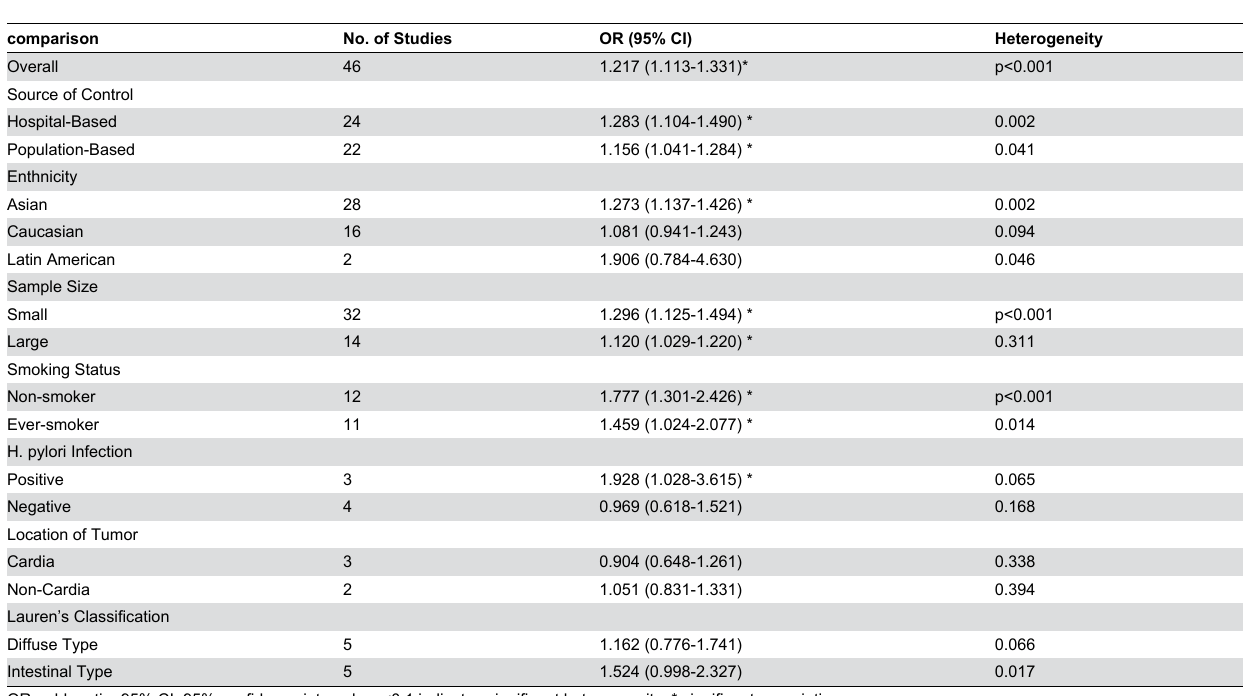
Table 2. Meta-analysis results of GSTM1 polymorphism and gastric cancer